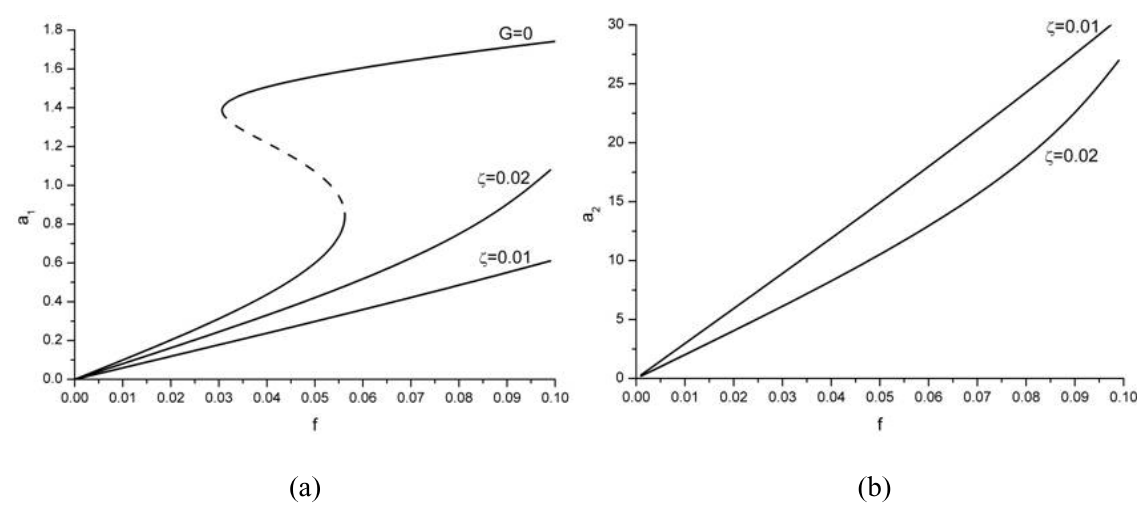
Fig. 12. Effect of varying the absorber’s damping on the force-response curves of (a) the plant and (b) the absorber when σ 1 = − 0 . 1 , G = 0 . 005 and ν 2 = 0 .